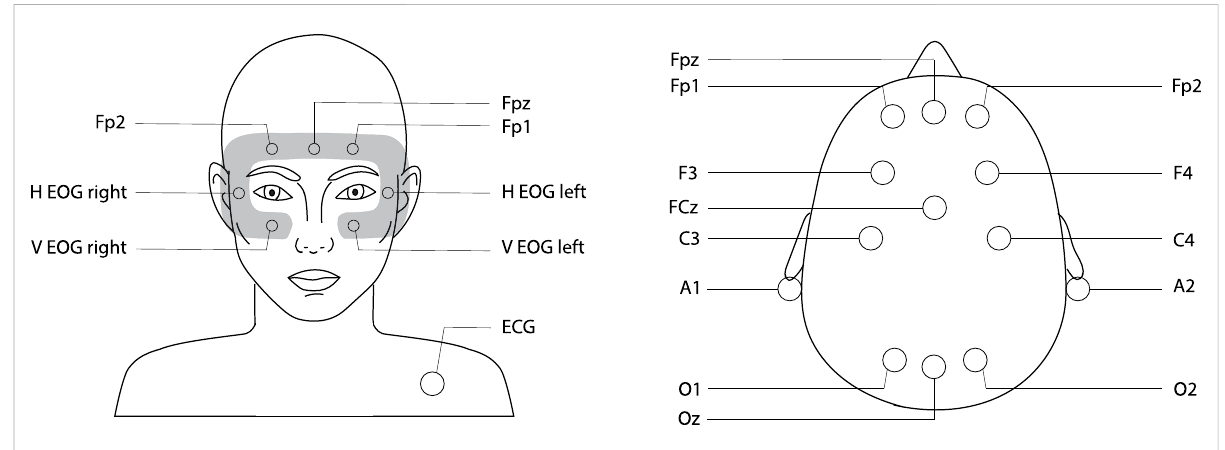
FIGURE 1 Locationsofthe16-ExGelectrodesplaceddirectlyontoaVRheadset.Left fi gureshowssensorsplacedonthefaceplateoftheheadsetandright fi gure those placed on the headset straps. Placement of electrodes follow the 10-10 international system (Sharbrough et al., 1991). EEG electrodes notation: Fp, Frontopolar; Fpz, Midline Frontopolar; F, Frontal; FCz, Midline Frontocentral; C, Central; O, Occipital; OZ, Midline Occipital.